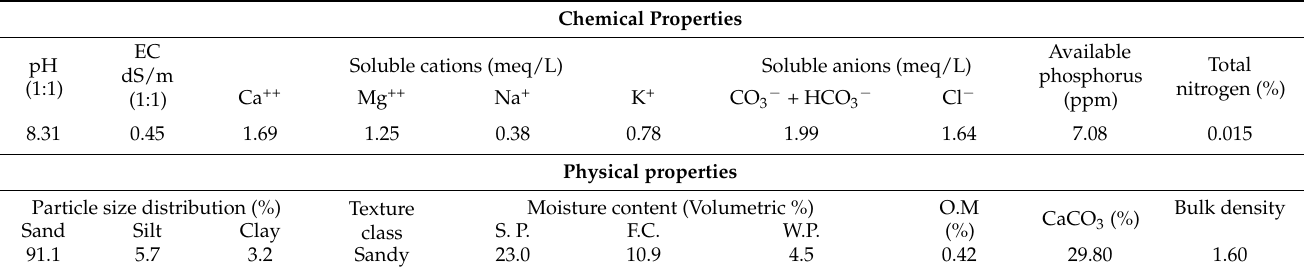
Table 2. Physical and chemical characteristics of representative composite soil samples from surface layer (0–25 cm) of Arab El-Awammer Research